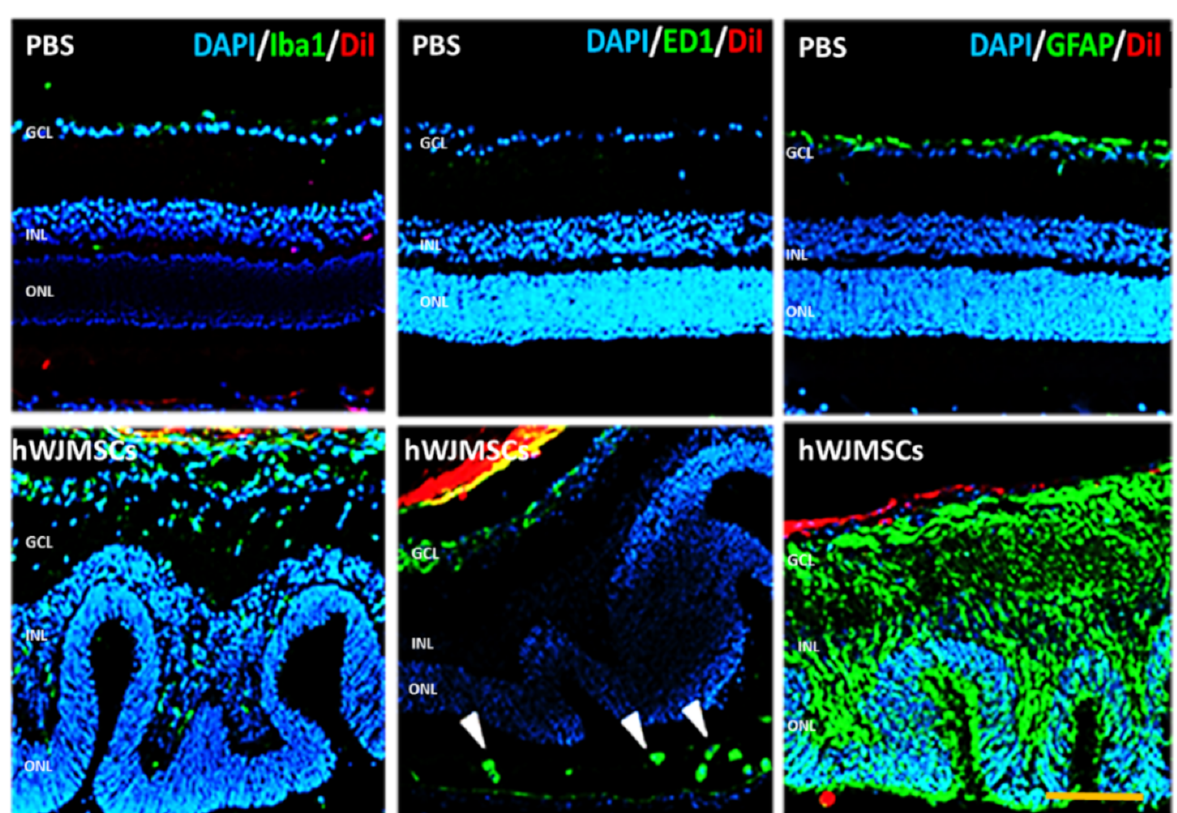
Figure 4. Immunoreactivity of Iba1, ED1, and GFAP in the retina after hWJMSCs transplantation. Representative image of microglia (Iba1+), macrophage (CD68+), and astrocyte (GFAP+) in each group. The confocal image showed the retinal inflammation 28 days after hWJMSCs transplantation. ED1-positive cells infiltrated into the subretinal space (arrowheads). Scale bar: 100 µ m. DAPI: 4, 6-diamidino-2-phenylindole; Iba1: ionized calcium binding adaptor molecule 1; ED1: Macrosialin; GFAP: Glial fibrillary acidic protein; DiI: 1,1’-Dioctadecyl-3,3,3’,3’-Tetramethylindocarbocyanine Perchlorate. GCL: ganglion cell layer; INL: inner nuclear layer; ONL: outer nuclear